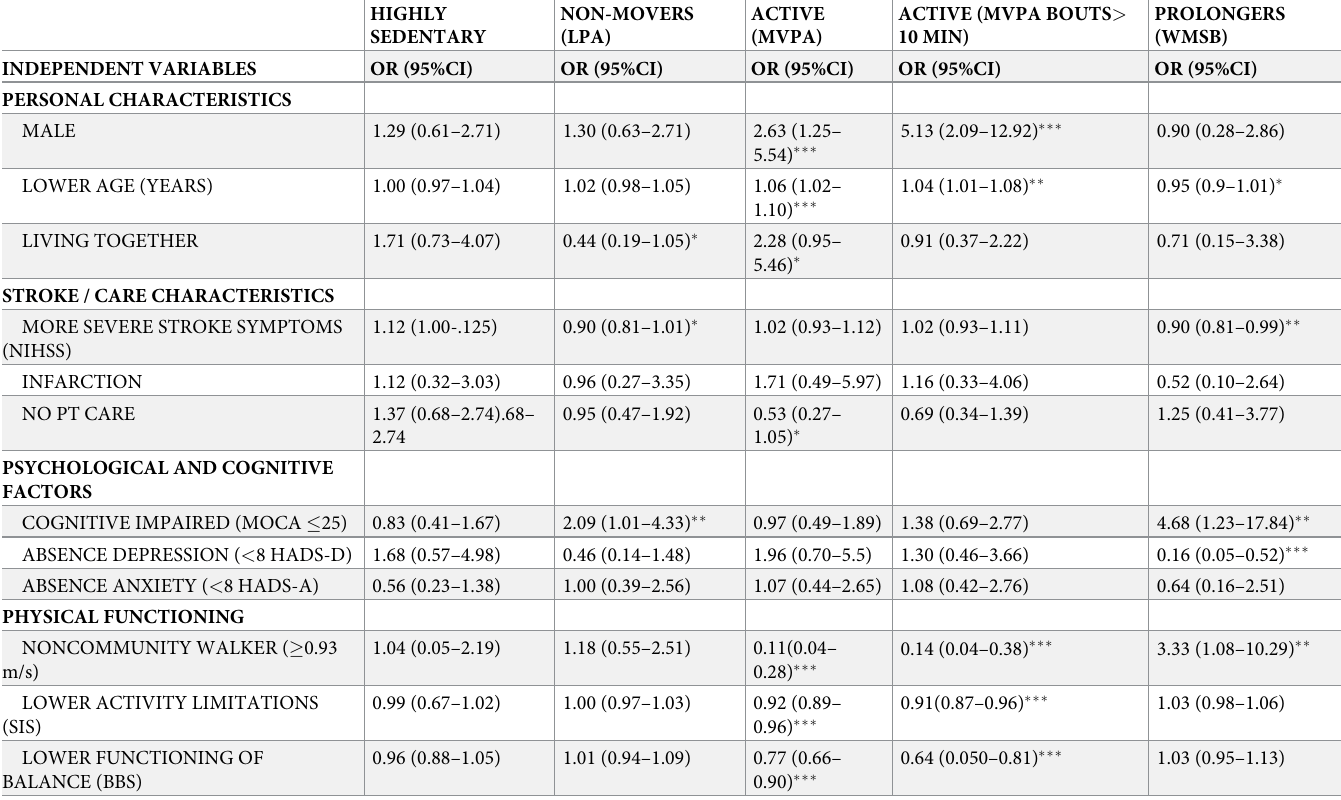
Table 4. Associated factors with highly sedentary, non-movers, active and prolongers using univariate